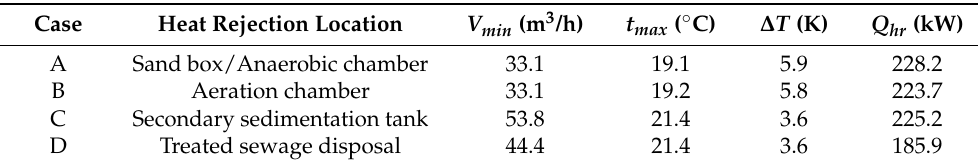
Table 4. Results of calculating the potential for heat discharge to wastewater at different locations at the treatment plant during summer.